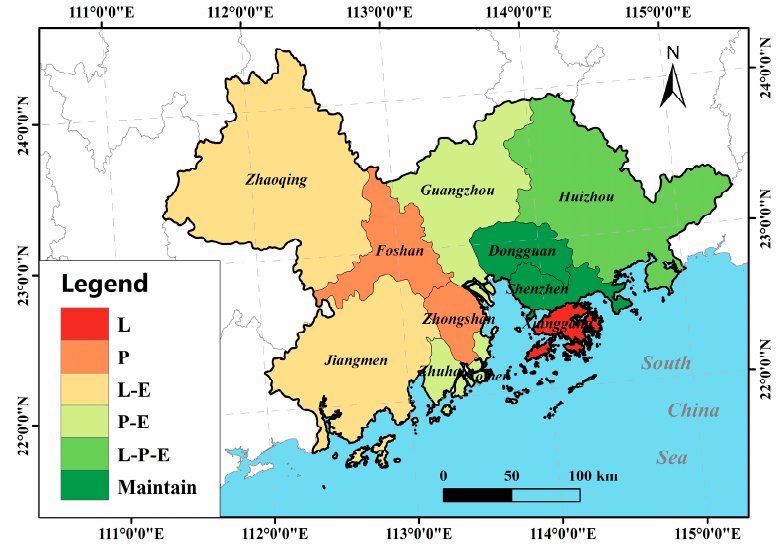
Figure 9. The spatial development direction of the local-level cities. Except for the maintenance area, the other areas need to be optimized and adjusted (P, L, and E denote the production, living, and ecological spaces, respectively). Table 8. Production-living-ecological space optimization plan for prefecture-level cities with declining levels of sustainable